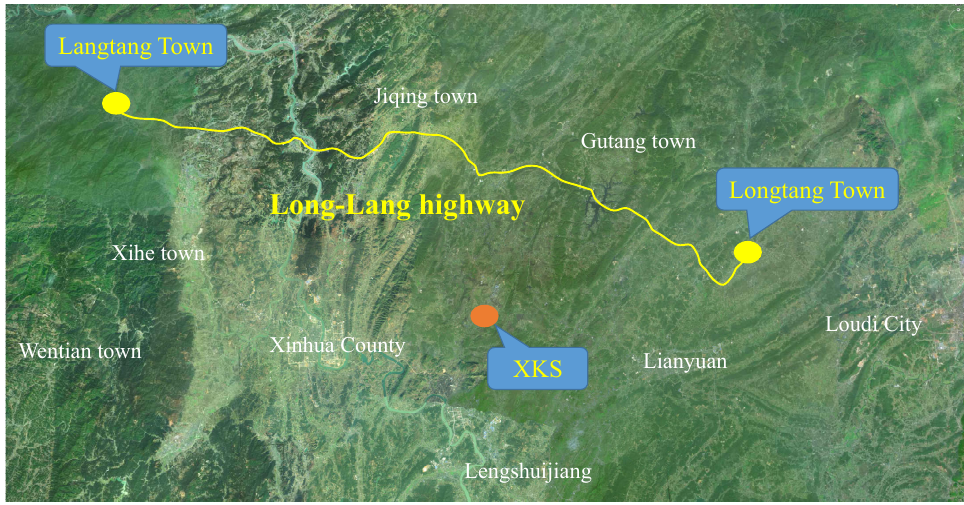
Figure 2. The location of Long ‐ lang highway project and XKS.